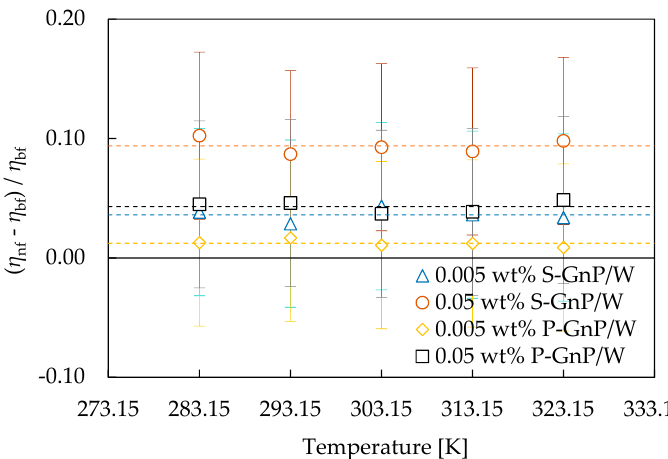
Figure 3. Dynamic viscosity increases for the different S-GnP and P-GnP nanofluids at temperatures from 283.15 to 323.15 K.